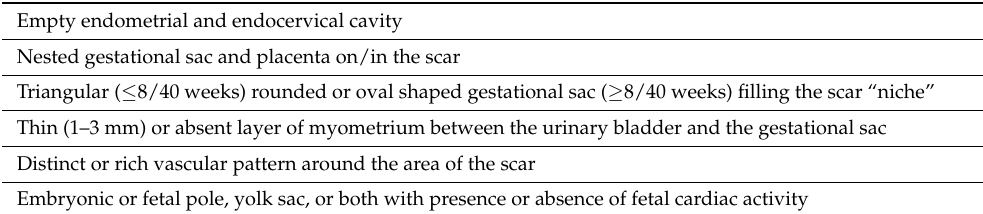
Table 1. Diagnostic ultrasonographic findings of CSPs. Empty endometrial and endocervical